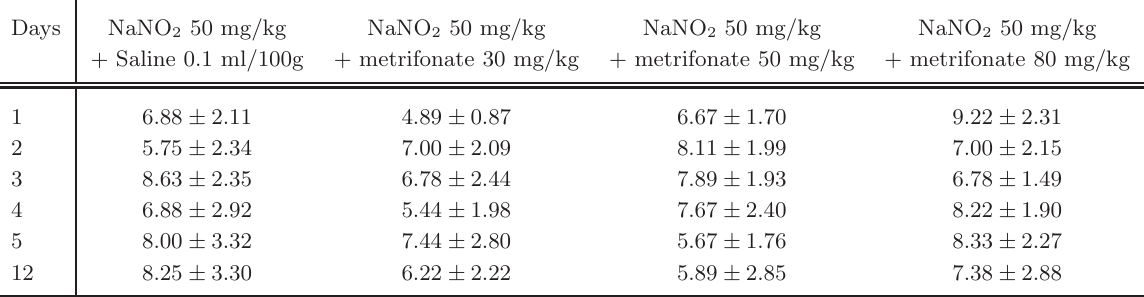
Table 3 Effects of metrifonate on active avoidance test (shuttle box) in a model of hypoxia: number of unconditioned stimuli responses (escapes).